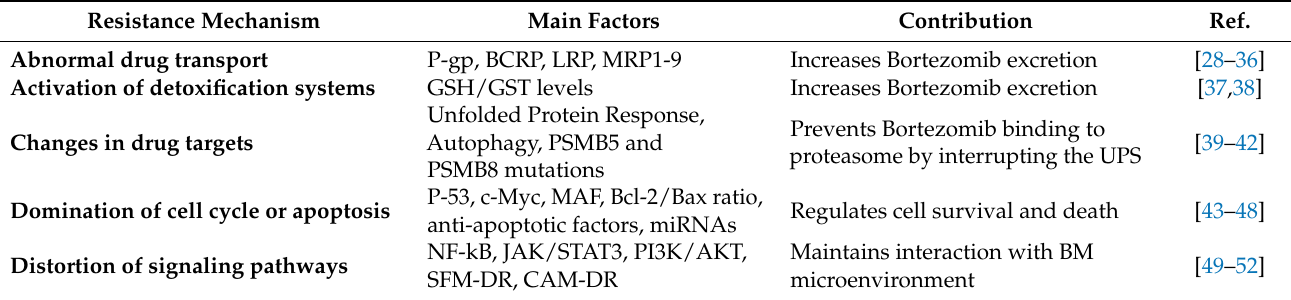
Table 2. Summary table of Bortezomib resistance mechanisms in